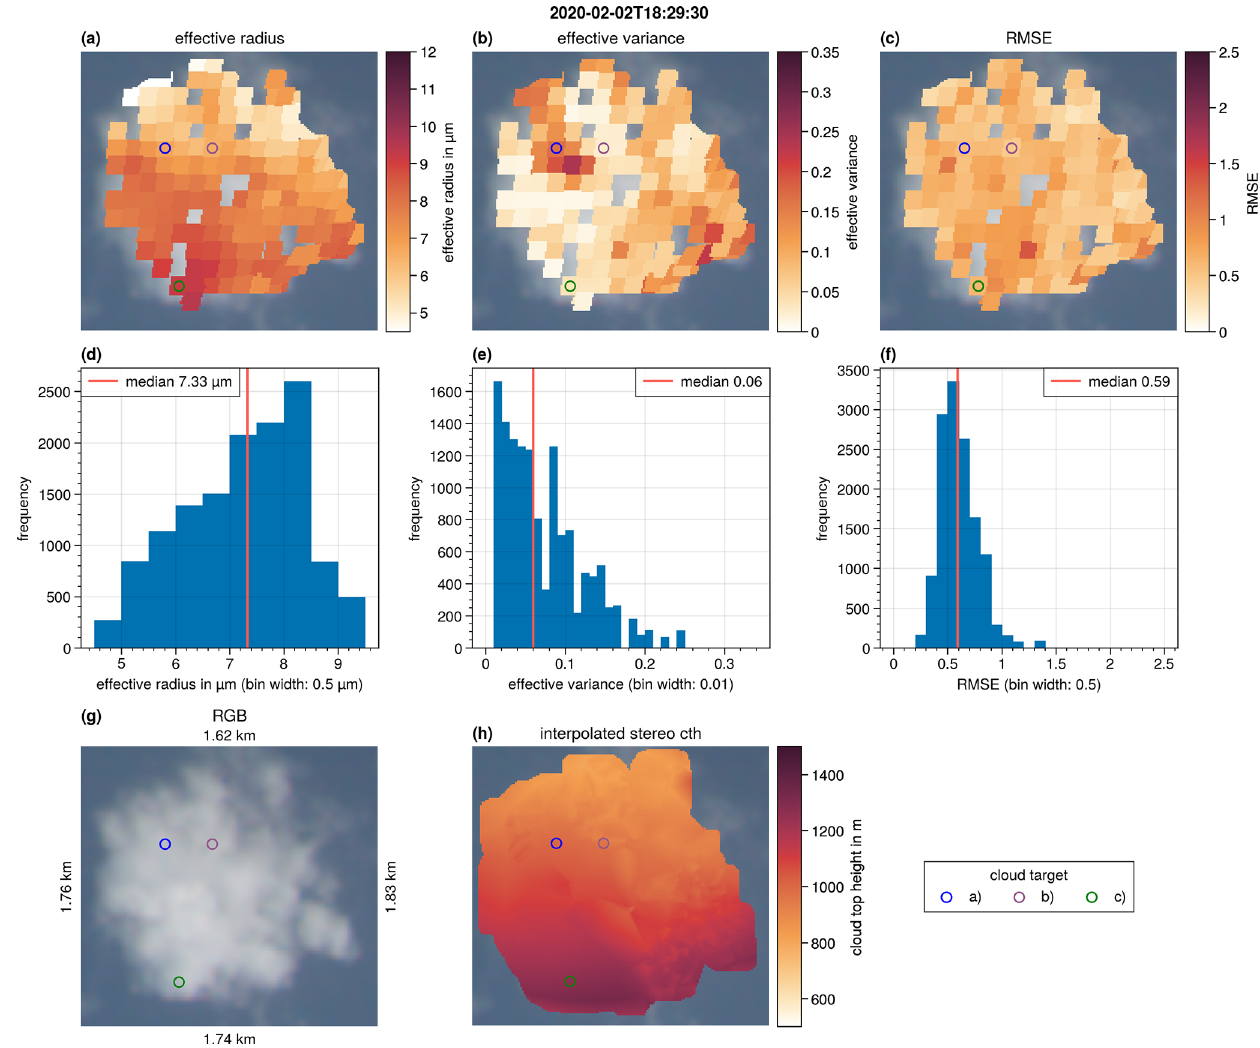
Figure 14. Same as in Fig. 7 but for a zoom into one cloud shown in case study 2 (Figs. 10 and 12). Three specific cloud targets are indicated by colored circles on the